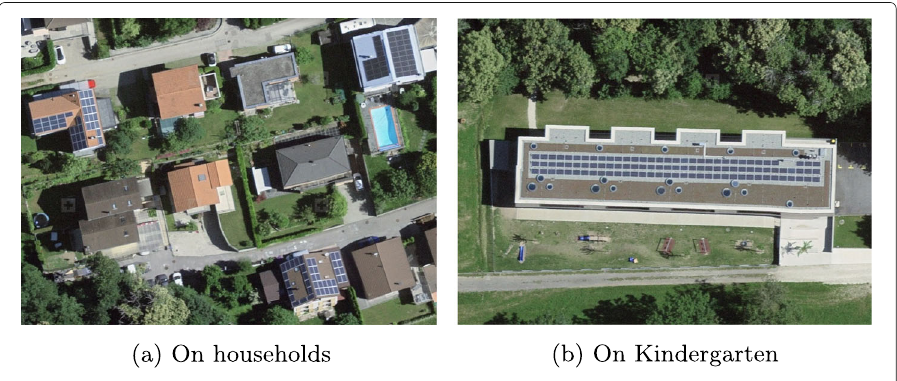
Fig. 1 Photovoltaic installations, source: